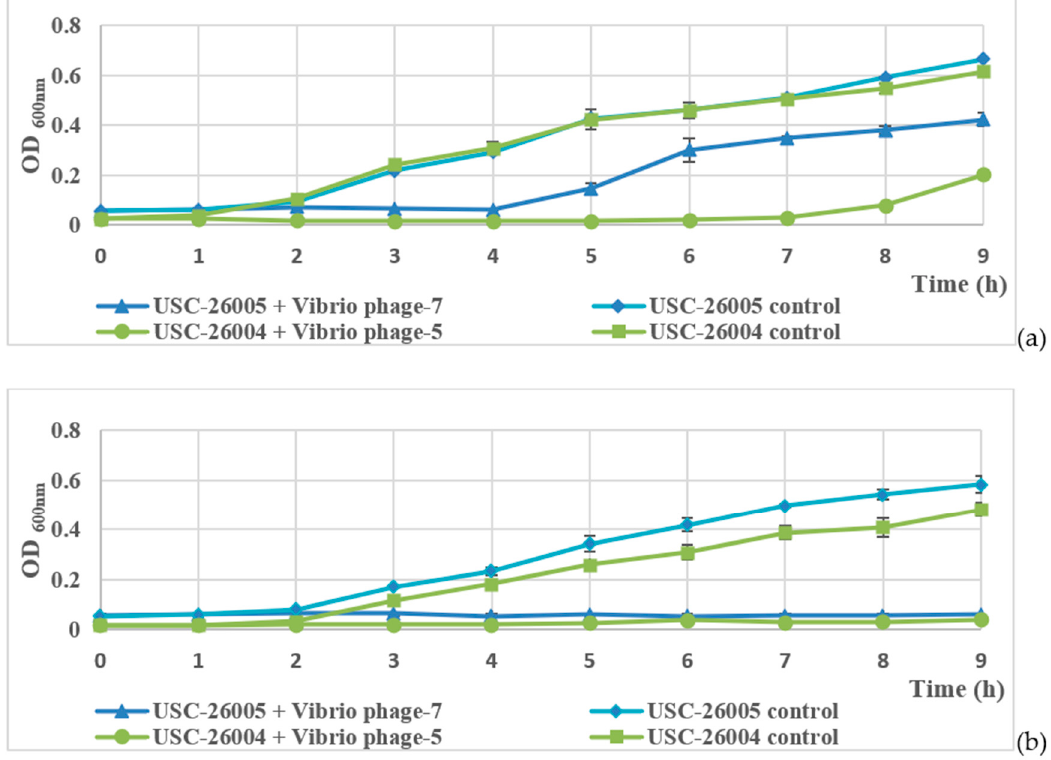
Figure 5. Inactivation of Vibrio spp. by the bacteriophages. Initial concentrations of Φ -6 and Φ -7 were × 10 6 PFU / mL. ( a ) LB broth: The initial concentrations of the isolates USC-26005 + Φ -7, USC-26006 control, USC-2004 + Φ -5 and USC-2004 control were 6.21 ± 0.05 × 10 6 , 6.11 ± 0.09 × 10 6 , 4.04 ± 0.2 × 10 6 and 4.04 ± 0.2 × 10 6 CFU / mL, respectively. ( b ) A mixture of seawater and LB broth at a ratio of 3:1: The initial concentrations of the isolates USC-26005 + Φ -7, USC-26006 control, USC-2004 + Φ -5 and USC-2004 control were 6.24 ± 0.1 × 10 6 , 5.92 × 10 6 , 3.62 ± 0.05 × 10 6 and 3.59 ± 0.12 × 10 6 CFU/mL, respectively.